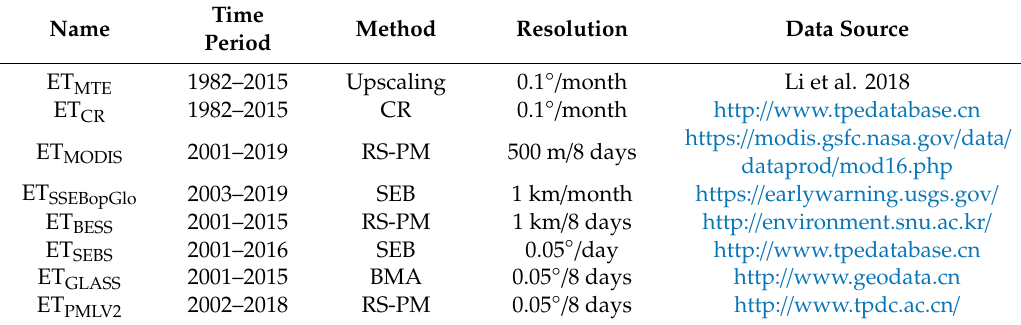
Table 1. Basic information about each evapotranspiration (ET)